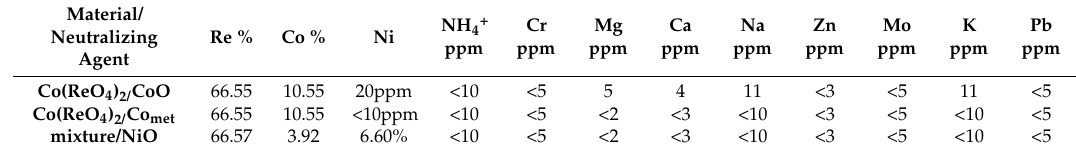
Table 14. Composition of cobalt(II) perrhenate and its mixture with nickel.